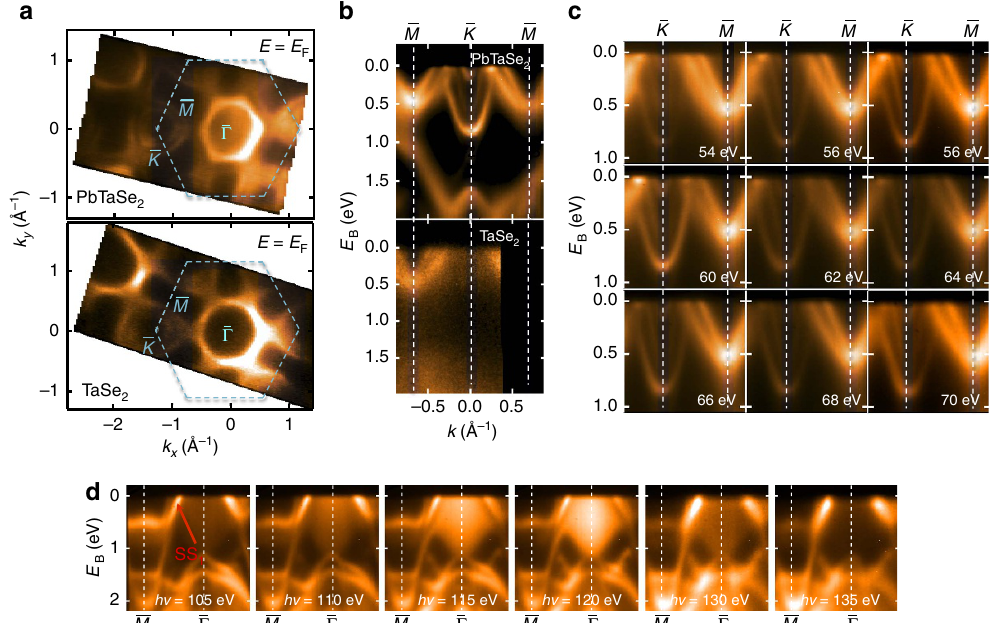
Figure 4 | APPES measurement of PbTaSe 2 and TaSe 2 . ( a ) Fermi surface contour of PbTaSe 2 and TaSe 2 . ( b ) APRES spectral cut along (cid:2) M (cid:2) (cid:2) K (cid:2) (cid:2) M of PbTaSe 2 (top) and TaSe 2 (bottom). ( c ) ARPES spectra of PbTaSe 2 along (cid:2) K (cid:2) (cid:2) M taken with different photon energies. ( d ) ARPES spectra along (cid:2) G (cid:2) (cid:2) M taken with different photon energies.